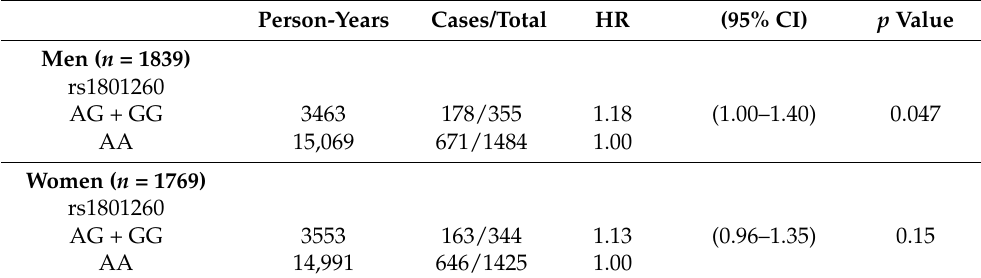
Table 4. Hazard ratios (HR) 1 for metabolic syndrome depending on the CLOCK rs1801260 genotype.